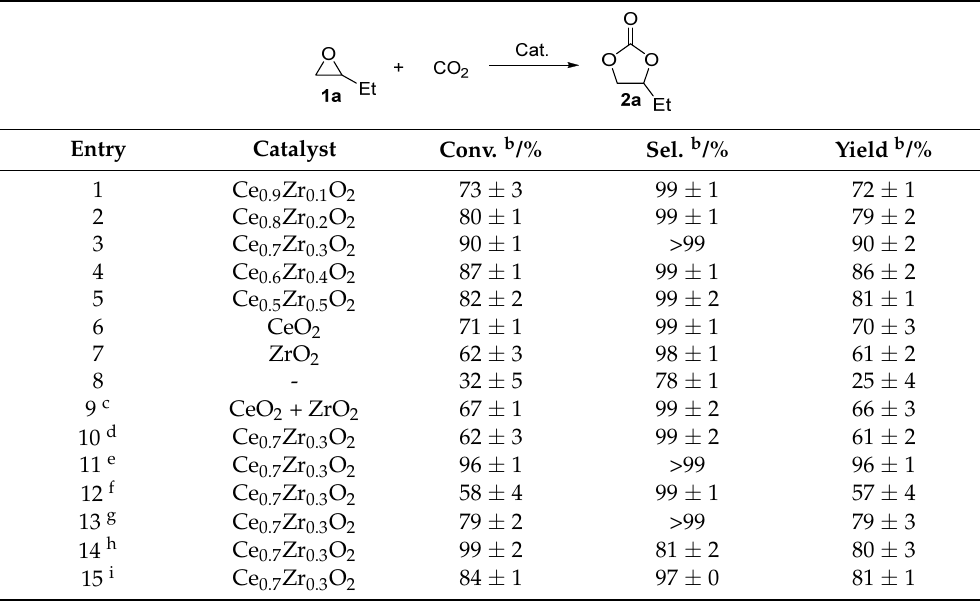
Table 4. Catalytic activity of various catalysts for the cycloaddition of CO 2 with 1a a .